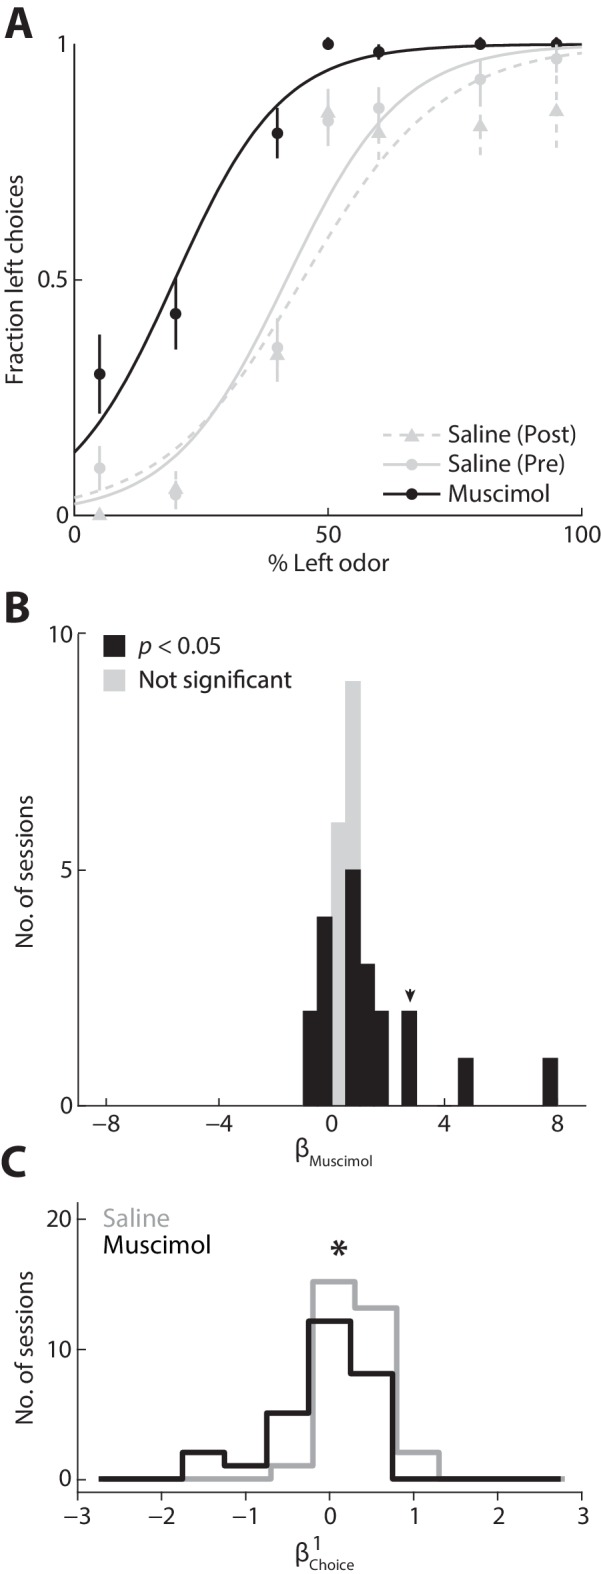
Inactivating the PPTg causally affects behavior.(A) Behavioral performance during example sessions after which either muscimol (black circles) or 0.9% saline (gray circles) was infused into the left PPTg. Saline was infused during the session before (gray circles, solid gray line) and after (gray triangles, dashed gray line) the muscimol session. One session was performed per day. Lines show best-fit logistic functions using the Simple model. Error bars, ± s.d. Behavioral data shown here and in all subsequent figures were collected from well-trained mice (Materials and methods). (B) βMuscimol calculated for all 3 mice and 30 sets of sessions. Positive values represent leftward (ipsilateral) influence of muscimol. Arrowhead indicates βMuscimol for example sessions shown in A. (C) Behavioral influence of the previous choice calculated separately for muscimol and saline sessions (same sessions shown in B). *p=0.021, one-tailed Mann-Whitney U test.